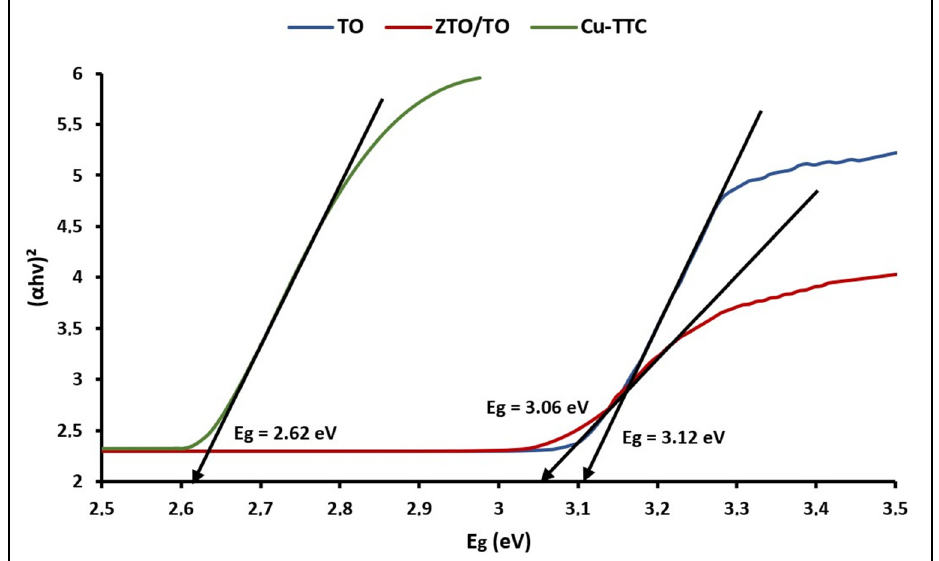
Figure 4. Plots of ( α hv) 2 vs. E g of TO, ZTO/TO and Cu-TTC. The bandgap (E g ) energy values were 3.12, 3.07 and 2.62 eV for TO, ZTO/TO and Cu-TTC, respectively. According to the literature, the E g value estimated for ZTO/TO can be related to the direct bandgap of ZTO [72].